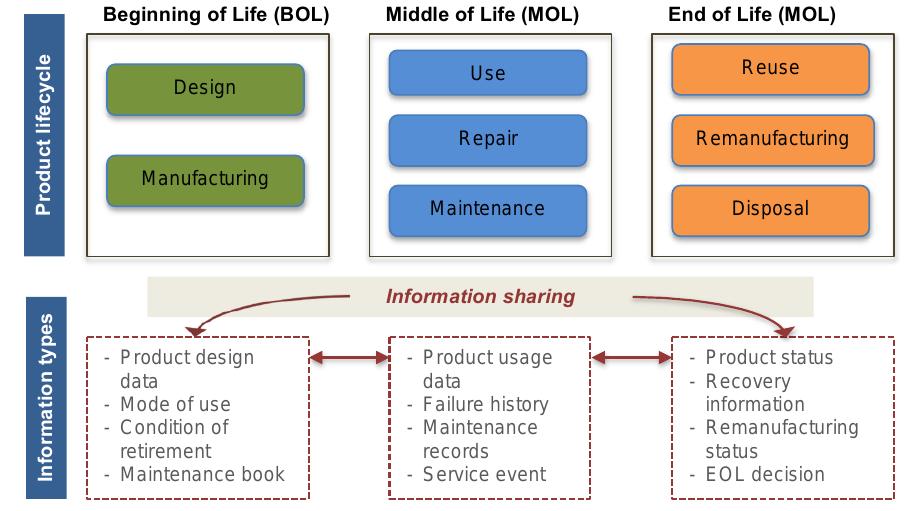
Figure 1. Product lifecycle management and information closing.